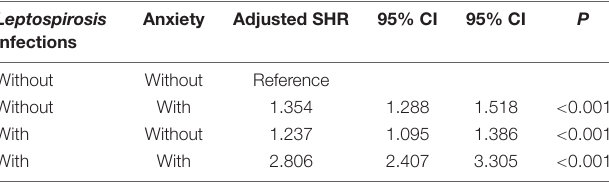
TABLE 7 | The interaction between Leptospirosis infections and anxiety for the risk of